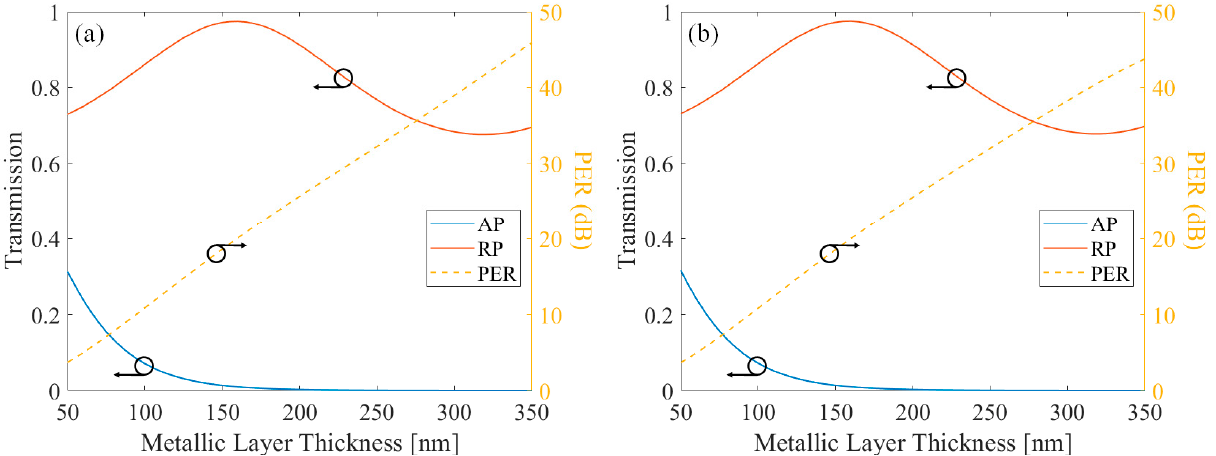
Figure 5. The AP component transmission, RP component transmission, and their PER of the protective layer applied MSCRA in terms of metallic layer thickness. The direction of the light is ( a ) Substrate to free-space and ( b ) Free-space to substrate.